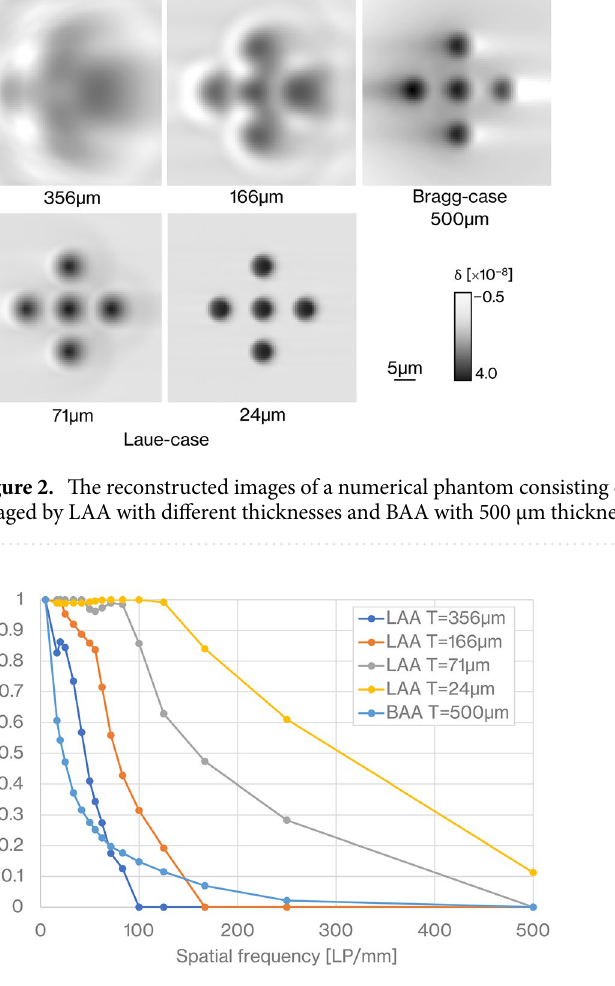
Figure 3. MTFs at different spatial frequencies, calculated from a line profile across the center of three circles arranged horizontally on the CT image of the phantom shown in Fig.